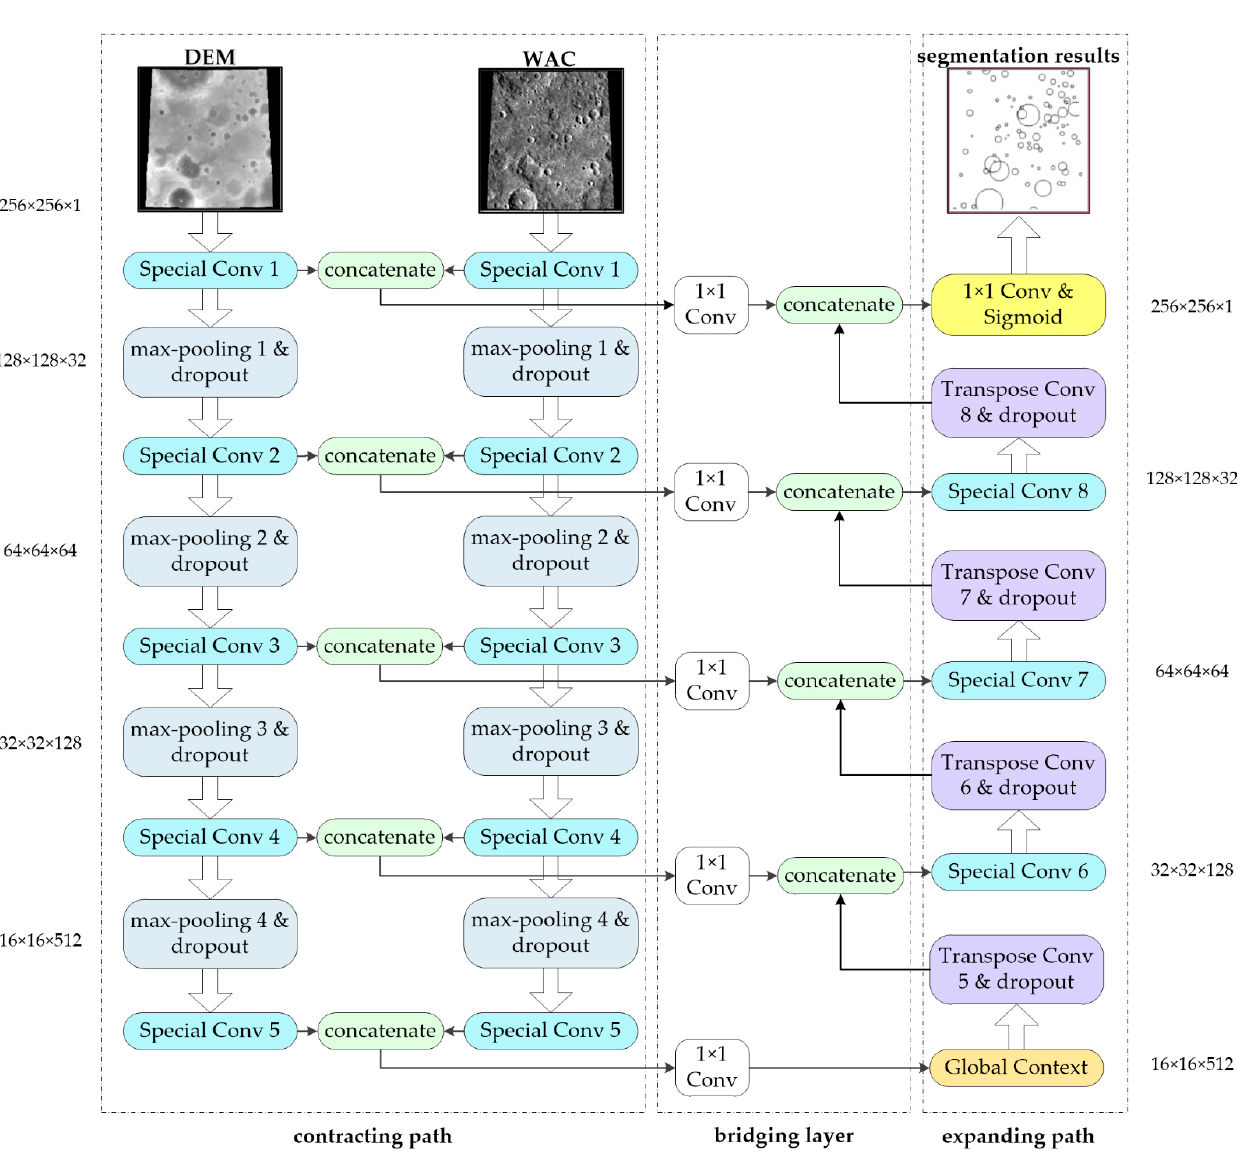
Figure 4. Architecture of the U-Net-based Dual-Path model proposed. It consists of a contracting path, bridging layer, and expanding path. Table 2. Feature maps of the Dual-Path network structure.